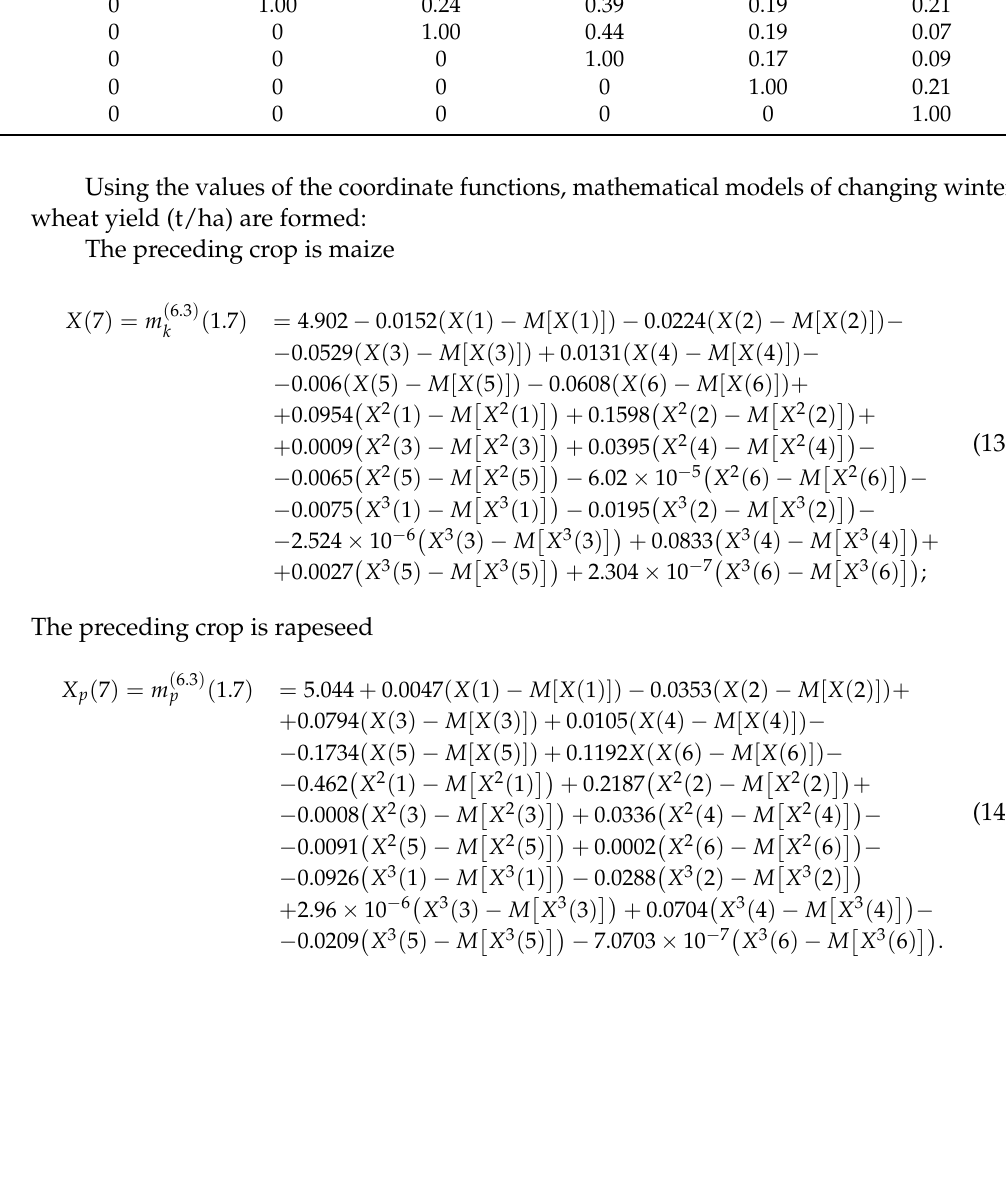
Table 9. Coordinate functions β